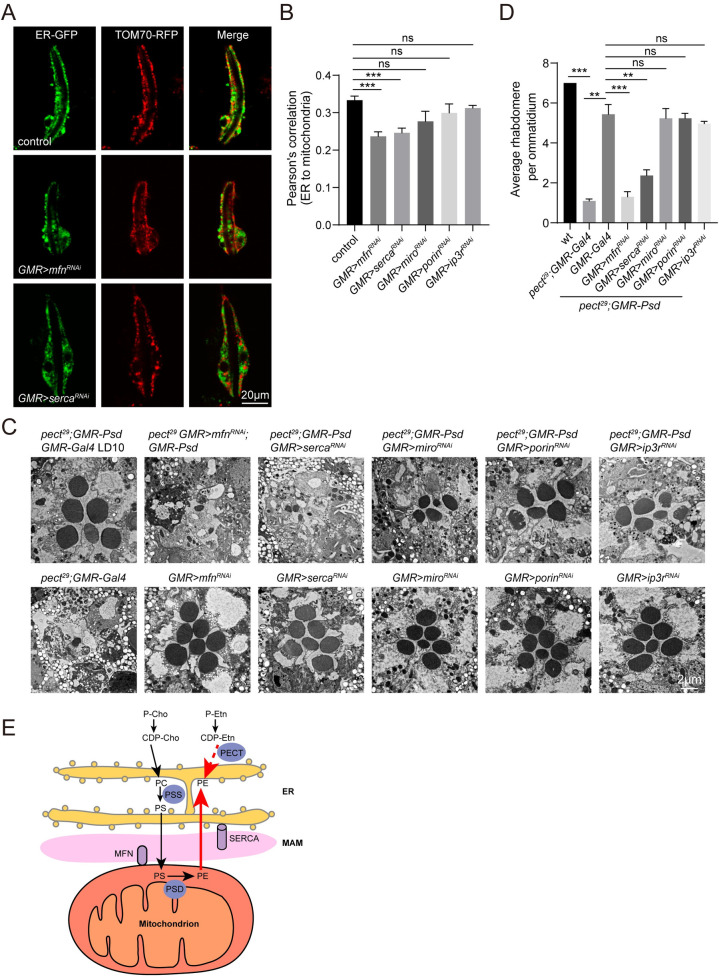
ER-mitochondria contacts are required for the function of PSD in PECT pathway.(A) Live confocal imaging of dissected ommatidia from control (ninaE-KDEL-GFP/+;trp-Tom70-RFP/+), GMR>mfnRNAi (UAS-mfnRNAi/ninaE-KDEL-GFP;longGMR-Gal4/trp-Tom70-RFP), and GMR>sercaRNAi (longGMR-Gal4/ninaE-KDEL-GFP;UAS-sercaRNAi/trp-Tom70-RFP). Scale bar is 20 μm. (B) Quantification of the Pearson’s correlation between ER and mitochondria in genotypes indicated. Three eyes from different flies and at least 20 ommatidia from each eye were quantified for each genotype. Data are presented as mean ± SD, ns, not significant, ***p < 0.001 (Student’s unpaired t-test). (C) TEM sections were obtained from pect29;GMR-Psd GMR-Gal4 (ey-flp rh1-GFP;pect29
FRT40A/GMR-hid CL FRT40A;GMR-Psd longGMR-Gal4/+), pect29
GMR>mfnRNAi;GMR-Psd (ey-flp rh1-GFP;pect29
FRT40A UAS-mfnRNAi/GMR-hid CL FRT40A;GMR-Psd longGMR-Gal4/+), pect29;GMR-Psd GMR>sercaRNAi (ey-flp rh1-GFP;pect29
FRT40A/GMR-hid CL FRT40A;GMR-Psd longGMR-Gal4/UAS-sercaRNAi), pect29;GMR-Psd GMR>miroRNAi (ey-flp rh1-GFP;pect29
FRT40A/GMR-hid CL FRT40A;GMR-Psd longGMR-Gal4/UAS-miroRNAi), pect29;GMR-Psd GMR>porinRNAi (ey-flp rh1-GFP;pect29
FRT40A/GMR-hid CL FRT40A;GMR-Psd longGMR-Gal4/UAS-porinRNAi), pect29;GMR-Psd GMR>ip3rRNAi (ey-flp rh1-GFP;pect29
FRT40A/GMR-hid CL FRT40A;GMR-Psd longGMR-Gal4/UAS-ip3rRNAi), pect29;GMR-Gal4, GMR>mfnRNAi (UAS-mfnRNAi/+; longGMR-Gal4/+), GMR>sercaRNAi (longGMR-Gal4/UAS-sercaRNAi), GMR>miroRNAi (longGMR-Gal4/UAS-miroRNAi), GMR>porinRNAi (longGMR-Gal4/UAS-porinRNAi) and GMR>ip3rRNAi (longGMR-Gal4/UAS-ip3rRNAi). All flies were raised for 10 days under 12h-light/12h-dark cycles. Scale bar is 2 μm. (D) Quantification of rhabdomeres per ommatidium in genotypes indicated. At least 10 ommatidia from each section of three different eyes were quantified for each genotype. Data are presented as mean ± SD, ns, not significant, **p < 0.01, ***p < 0.001 (Student’s unpaired t-test). The knock-down efficiencies of mfnRNAi, sercaRNAi, miroRNAi, porinRNAi, ip3rRNAi were 54%, 54%, 56%, 48% and 24%, respectively. (E) Model of lipid exchange between ER and mitochondria.PS is generated from PC or PE through PSS which is localized in the MAMs. PS is then transported to the mitochondria inner membrane where PS is converted to PE through PSD. PE synthesized in the mitochondria is transported back to the ER upon cellular PE deficiency.